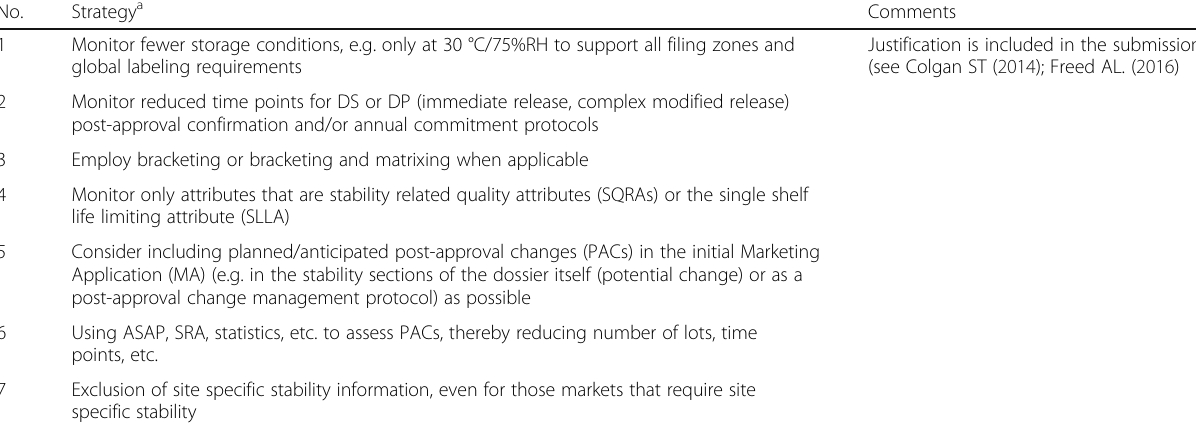
Table 3 Examples of Lean Stability Strategies in the Initial and Post-Approval Registration Dossiers No. Strategy